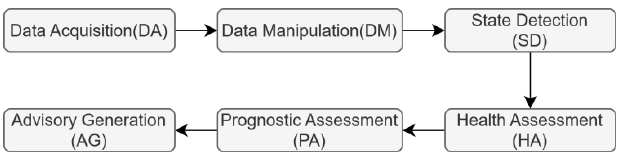
Figure 1: The six processing levels of ISO 13374. Source: